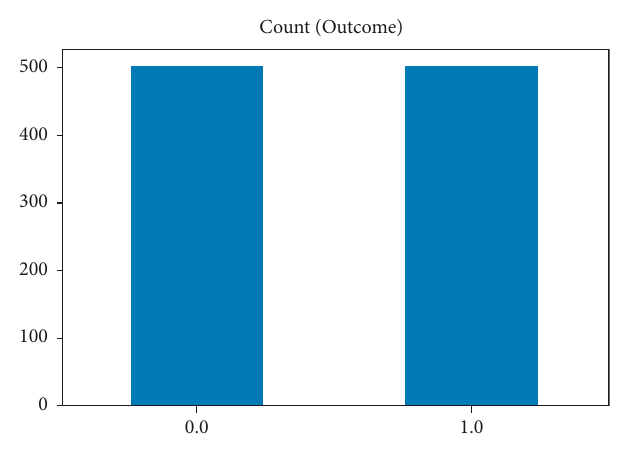
Figure 11: After